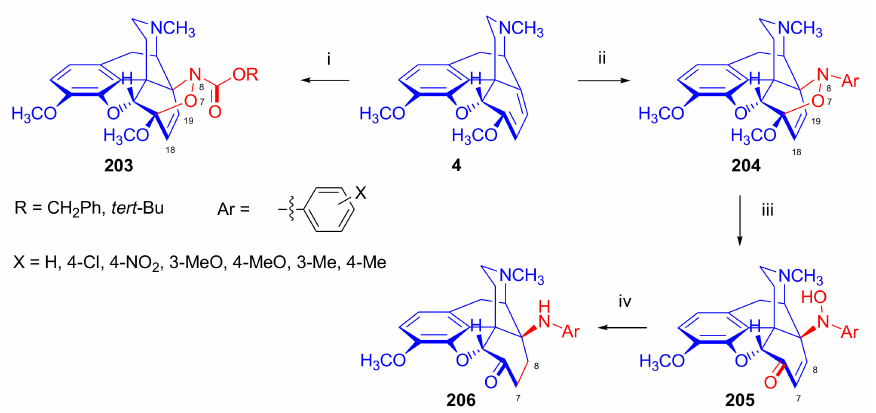
Figure 54. Cycloadducts of thebaine with nitrosoformates and nitrosoarenes. Reagents and conditions : (i): (A) ROCON 3 , ∆ , DMSO; or (B) hydroxamic acids, Et 4 NIO 4 , CH 2 Cl 2 , = 0 ◦ C, 1 h; (ii): ArNO, CHCl 3 , room temperature, 30 min; 65–97%; and (iii): 2M HCl, ∆ , 90%; (iv): H 2 , 10% Pd-C, MeOH, room temperature, atmospheric pressure, 4